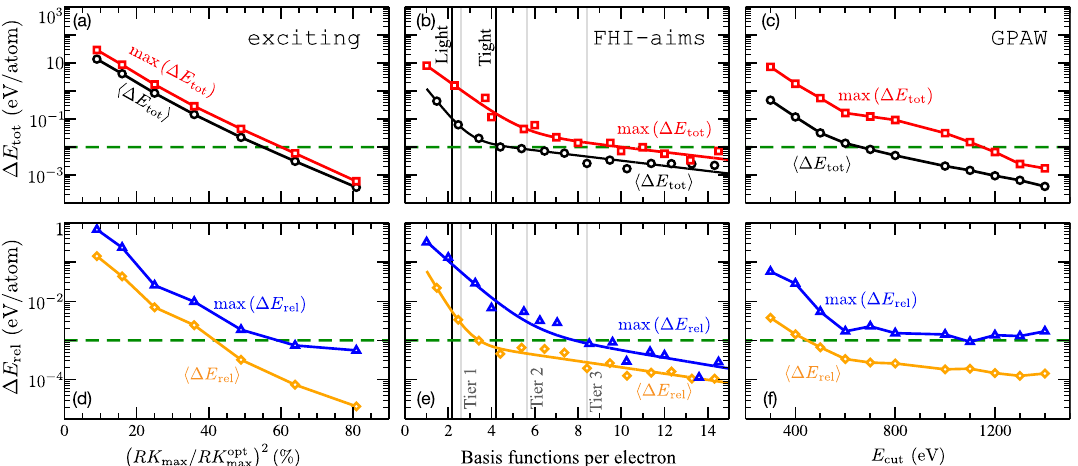
Fig. 1 Energy convergence with basis-set size. Average (black/orange) and maximum (red/blue) error in E tot ( a – c ) and E rel ( d – f ) are shown as a function of basis-set size. The data was obtained with exciting ( a , d ), FHI-aims ( b , e ), and GPAW ( c , f ) for the 71 elemental solids (PBE, 8 Å k-point density). Note that we use a logarithmic scale for the energy axis and different energy windows in the upper and lower row. See text for a discussion of the different metrics used in the different codes to quantify basis-set quality. The green dashed horizontal lines indicate values of typically wanted precision.